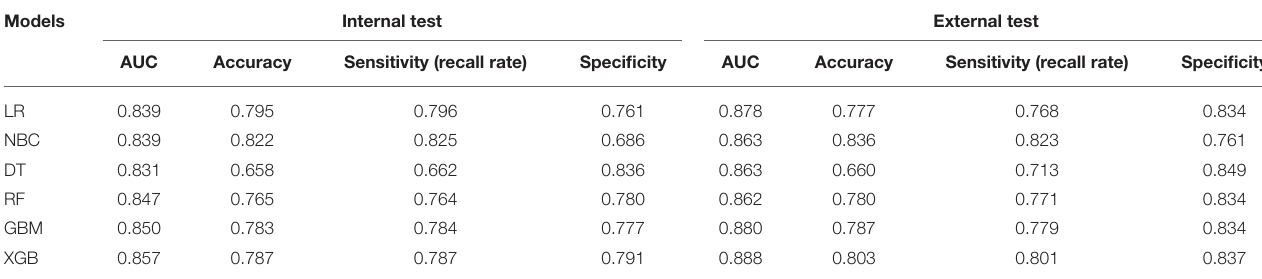
TABLE 4 | Comparison of prediction performances among different models for bone metastasis. Models